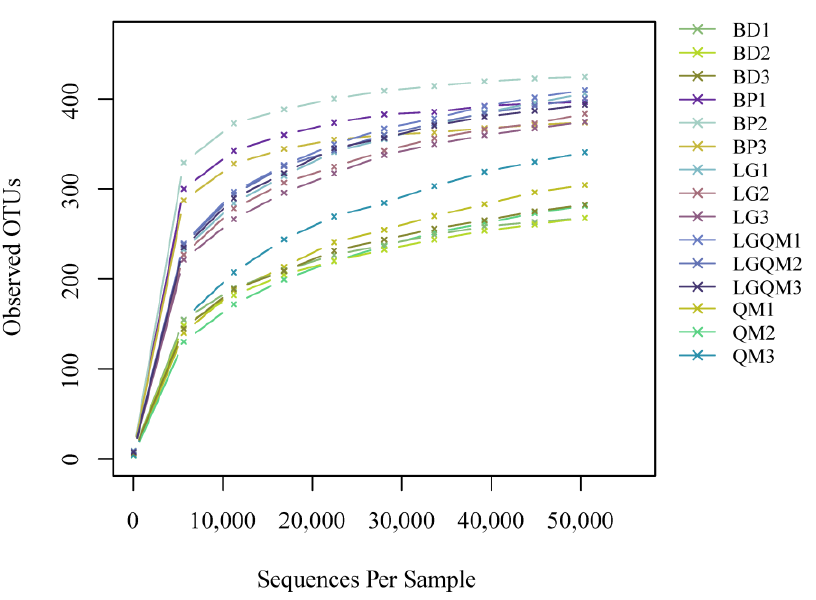
Figure 3. Rarefaction curves. BD1-BD3, B. dahurica ; BP1-BP3, B. platyphylla ; LG1-LG3, L. gmelinii ; LGQM1-LGQM3, Q. mongolica and L. gmelinii mixed forest; QM1-QM3, Q. mongolica . All the identified sequences were assigned to seven phyla and one unknown cate- gory. Basidiomycota (63.95%), Ascomycota (17.80%), Mortierellomycota (8.55%), and Mucoromycota (7.86%) were the primary phyla in the examined soil samples, account-